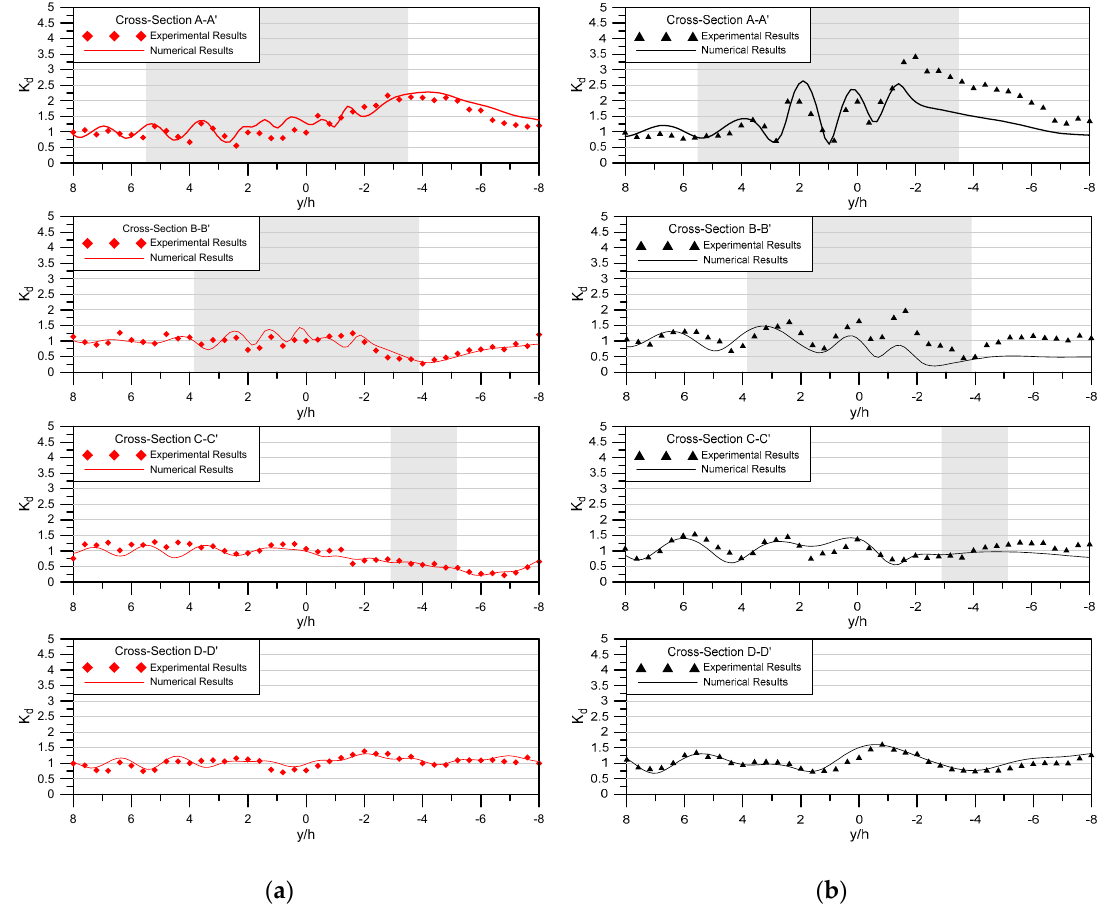
Figure7. Comparisonoftheexperimentalandnumericalwave-heightratios K d atdi ff erentcross-sections A–A’, B–B’, C–C’, and D–D’ for wave conditions of ( a ) σ 2 h / g = 2.012 and ( b ) σ 2 h / g = 0.894 at normal incidence. The shaded area indicates where the plate starts and ends for the given cross-section.